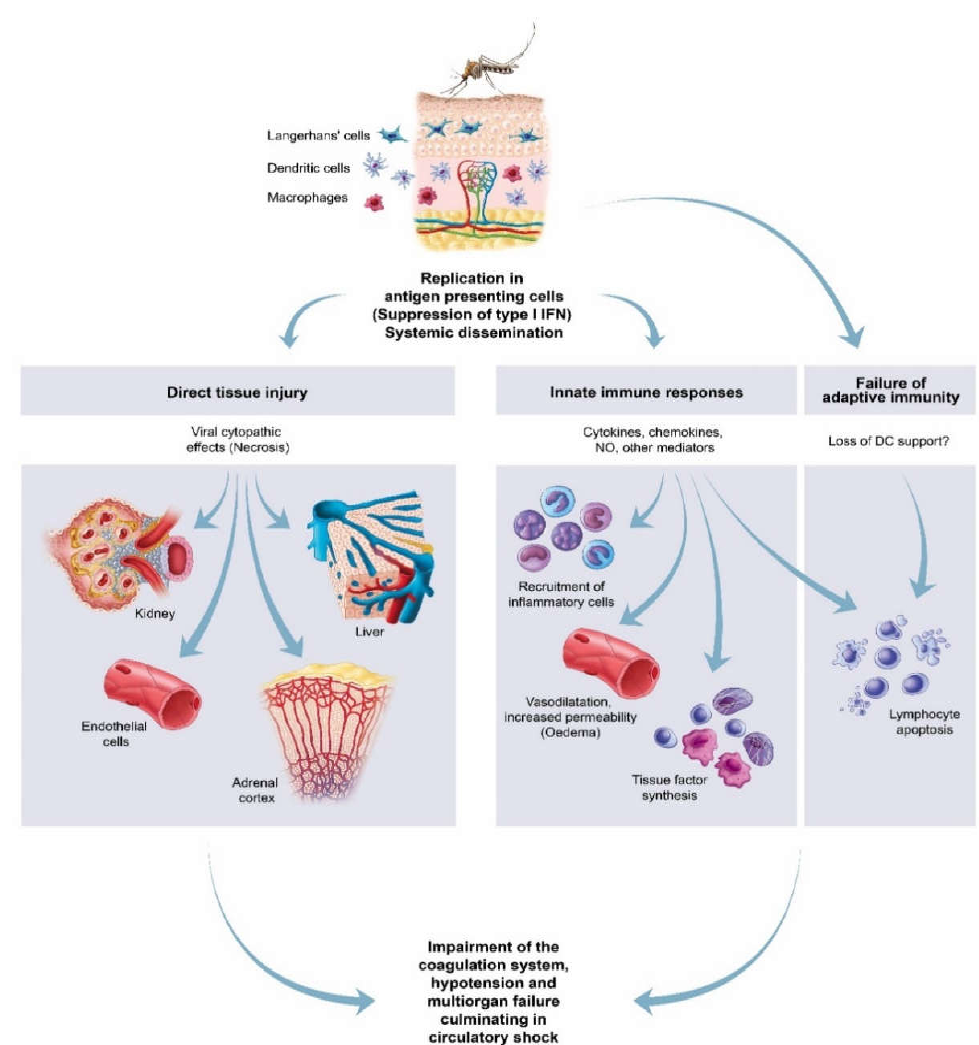
Figure 16. Model of the pathogenic mechanism underlying RVFV infection. Following a mosquito bite, the virus is endocytosed by antigen-presenting cells. Suppression of type I IFN production and necrosis of infected macrophages and dendritic cells cause wide dissemination of viruses. This systemic spread leads to necrosis in a variety of tissues and cells together with suppression of both the innate and adaptive immune responses. Apoptosis of lymphocytes might occur through mediator effects and loss of dendritic cell support, exacerbating the failure of the immune response. An excessive pro-inflammatory cytokine and chemokine response follow, resulting in increased microcirculatory dysfunction through the action of inflammatory mediators. Impairment of the coagulation system results in widespread haemorrhages. Fatal outcomes result from multiorgan failure, oedema in many organs (including the lungs and brain), hypotension and circulatory shock. DC, dendritic cell. NO, nitric oxide. (Illustration adapted from Bray M,